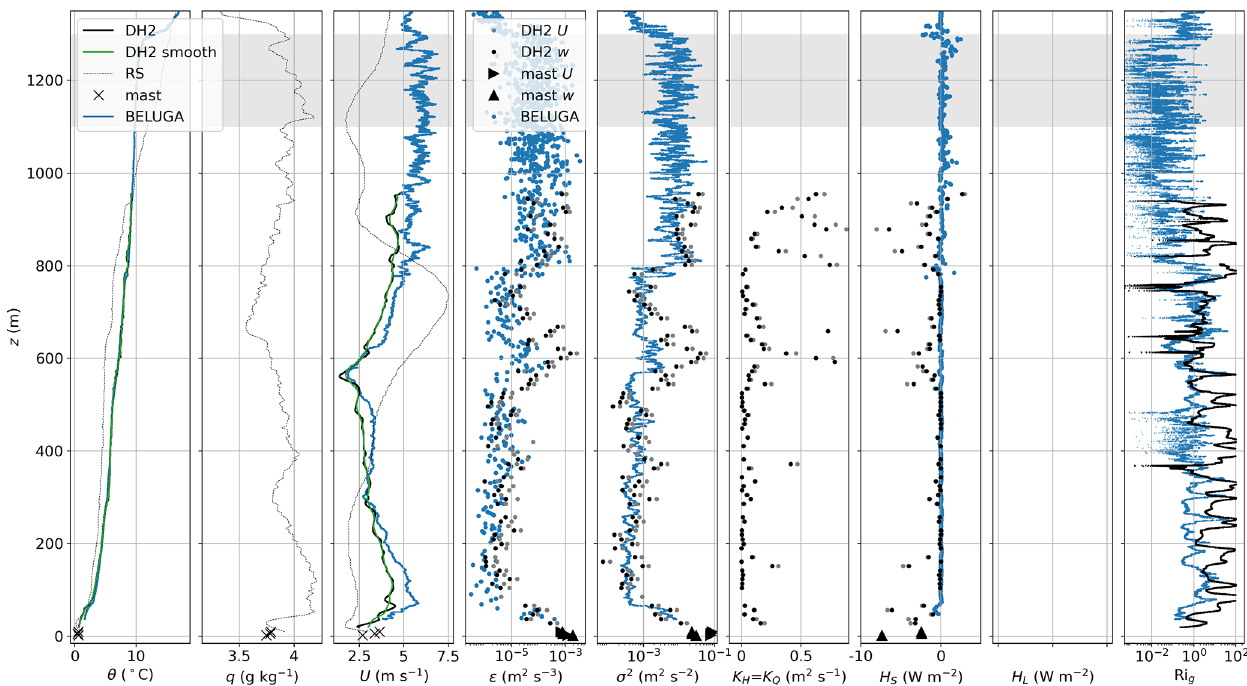
Figure 10. Vertical profiles for 13 July (first descent). Panels are as in Fig. 9, but no reliable q and H L data from the DH2 are available for this case.